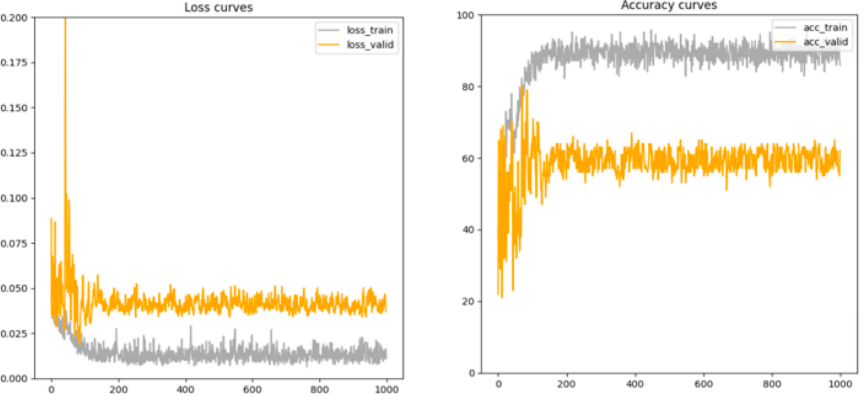
Figure 7. Accuracy and loss curves for the training and validation sets.